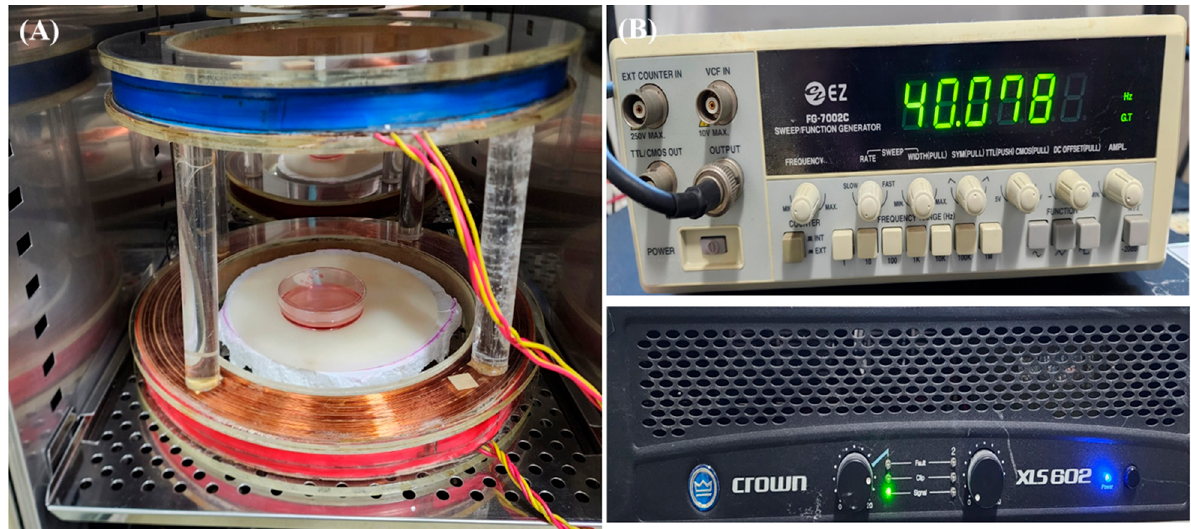
Figure 7. EMF stimulation device. ( A ) Helmholtz coils. ( B ) Function generator and amplifier. The coils were placed in a cell culture incubator (37 °C, 5% CO 2 ). EMF, electromagnetic field.